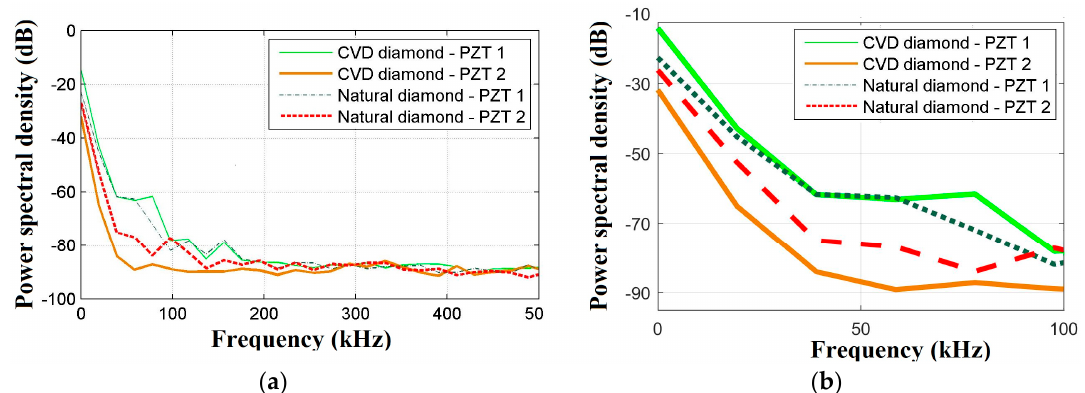
Figure 4. PLB test results: ( a ) frequency response analysis via PSD; and ( b ) enlarged view into the range of 0–100 kHz.